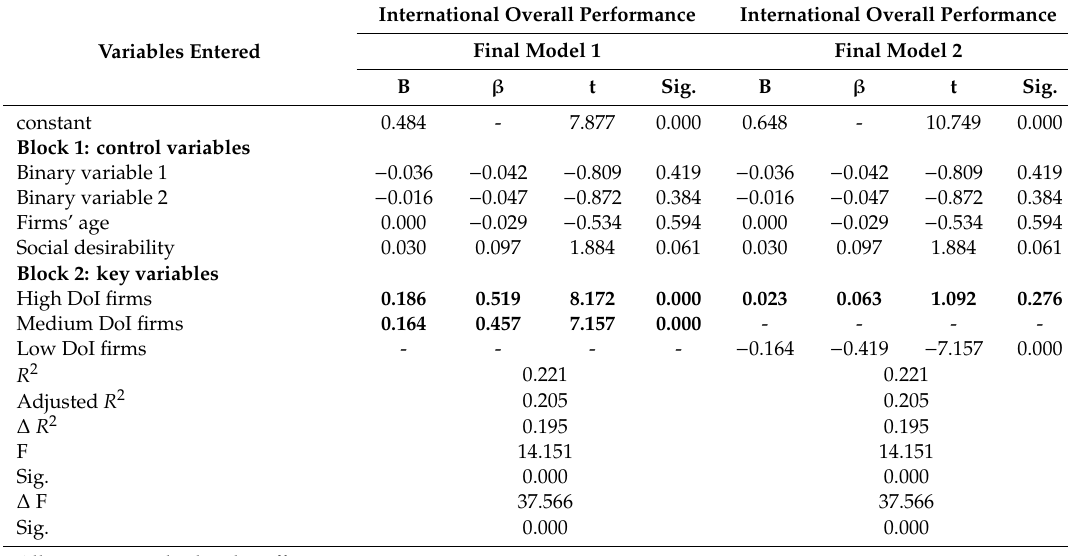
Table 4. Regression analysis (international overall performance).